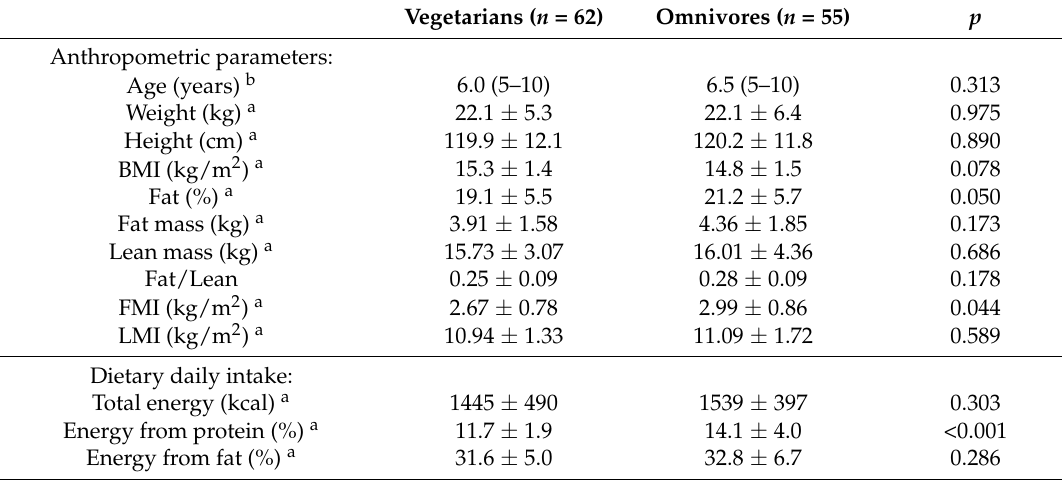
Table 1. Comparison of anthropometric parameters, and dietary energy and nutrient intakes between children on vegetarian and omnivorous